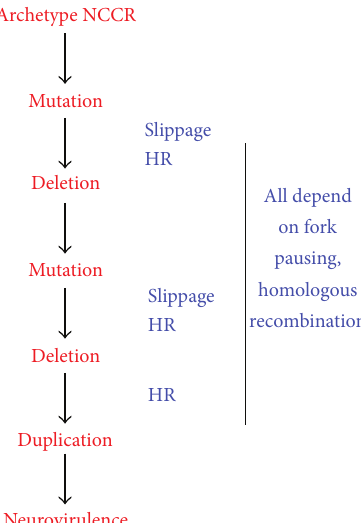
Figure 4: A sequential order of DNA sequence alterations in progression of the JCV archetype NCCR to a neurovirulent type. In this model mutations precede deletions, and deletions precede tandem duplication. Deletions may occur due to slippage and/or homologous recombination, and duplication may result from var- ious forms of recombination. The possibility of specialized forms of recombination, such as V(D)J-like recombination, occurring within this series cannot be ruled out. Both deletion and duplication may be triggered by dsb caused by replication fork pausing or stalling. No individual step, denoted by an arrow, need be an extremely rare event, but the end result, a neurovirulent JCV form, would be a